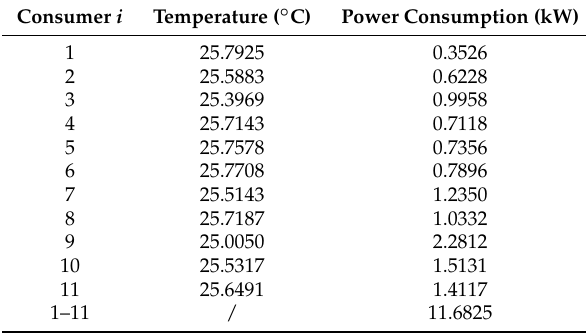
Table 6. The temperature settings and energy consumption in IEEE 14-bus